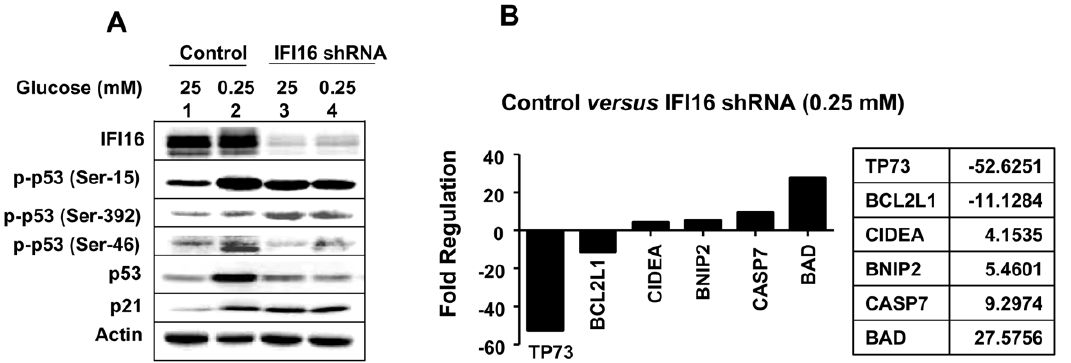
Figure 6. IFI16 protein potentiates the p53-mediated transcriptional activation through the regulation of phosphorylation. ( A ) Sub- confluent cultures of young WI-38 HDFs either infected with control (Vector) or IFI16 shRNA lentivirus particles (shIFI16) were incubated with the indicated concentrations (mM) of glucose in the medium supplemented with 10% fetal bovine serum for 18 h. At the end of the incubations, cells were lysed and equal amounts of proteins were analyzed by immunoblotting using antibodies specific to the indicated proteins. ( B ) Young WI-38 HDFs either infected with control or IFI16 shRNA lentivirus particles were incubated with medium containing reduced glucose concentration (0.25 mM) for 18 h. At the end of the incubation, total RNA was isolated and subjected cDNA synthesis. The cDNA preparation was used for RT 2 Profiler PCR Array for human apoptosis genes as described in Methods. Genes whose expression was increased or decreased more than 4-fold are indicated.